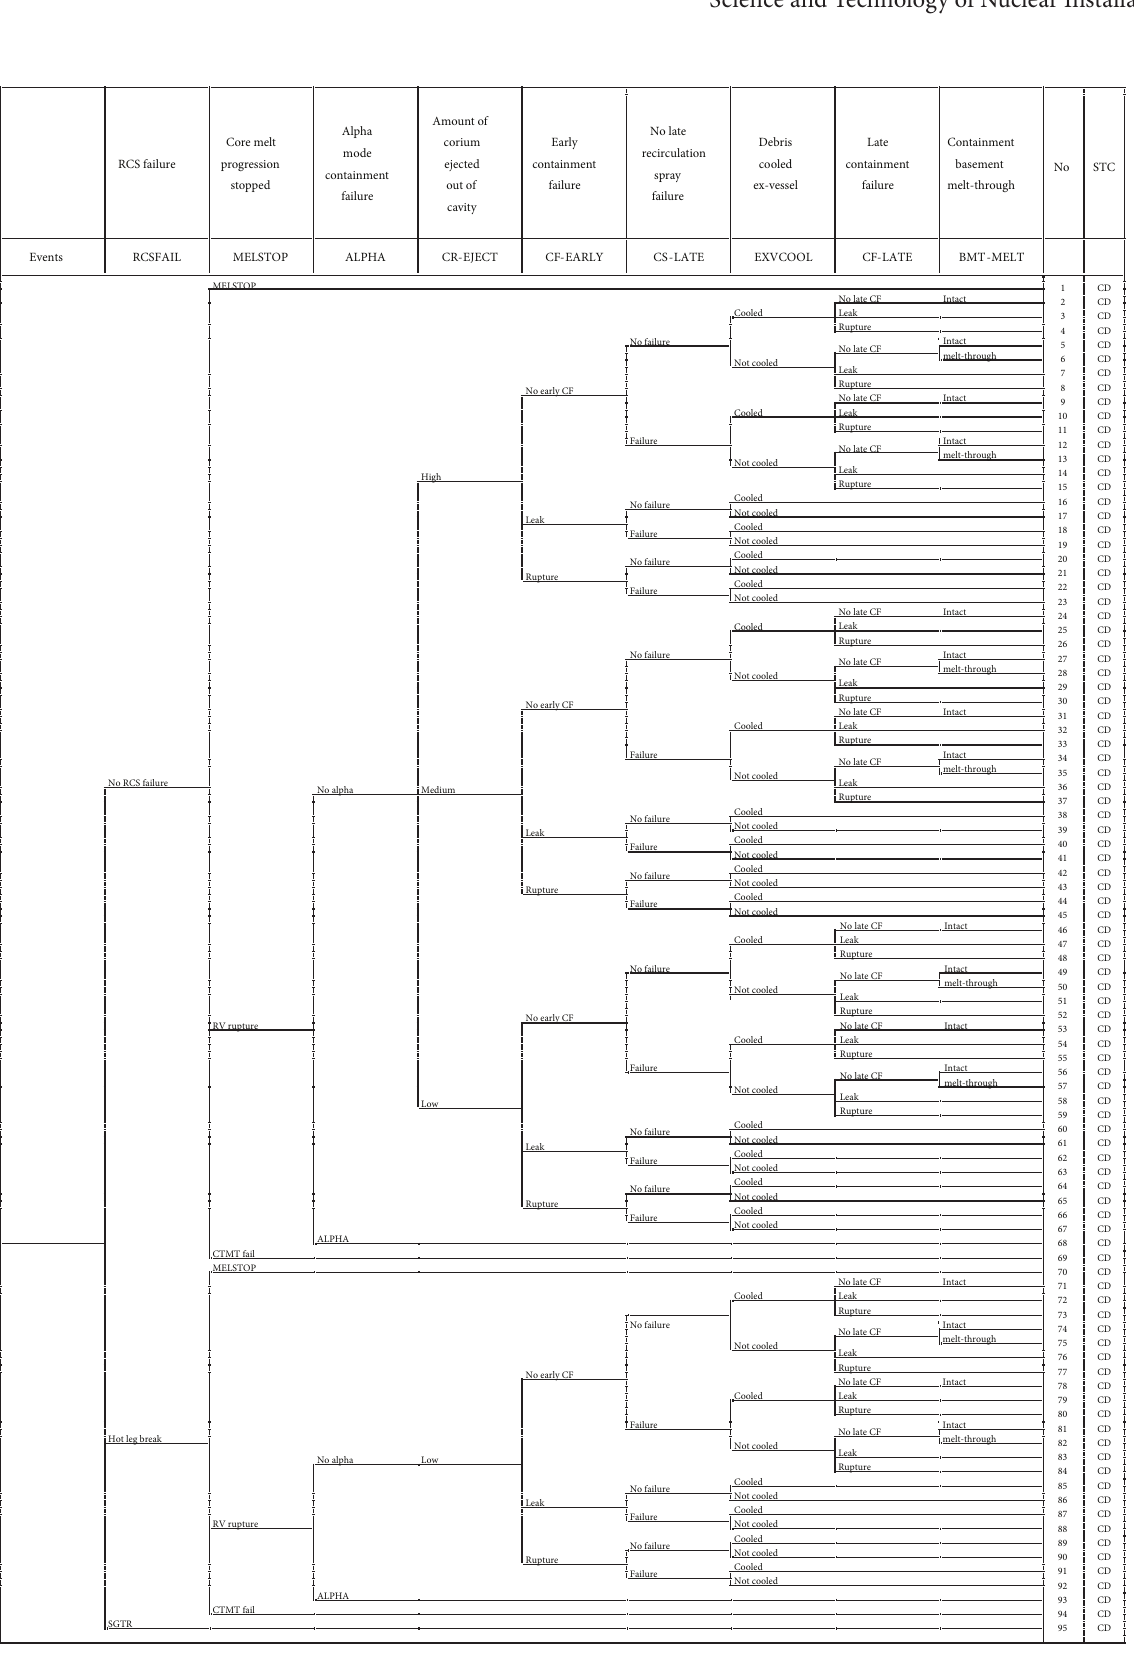
Figure 11: Representative containment event